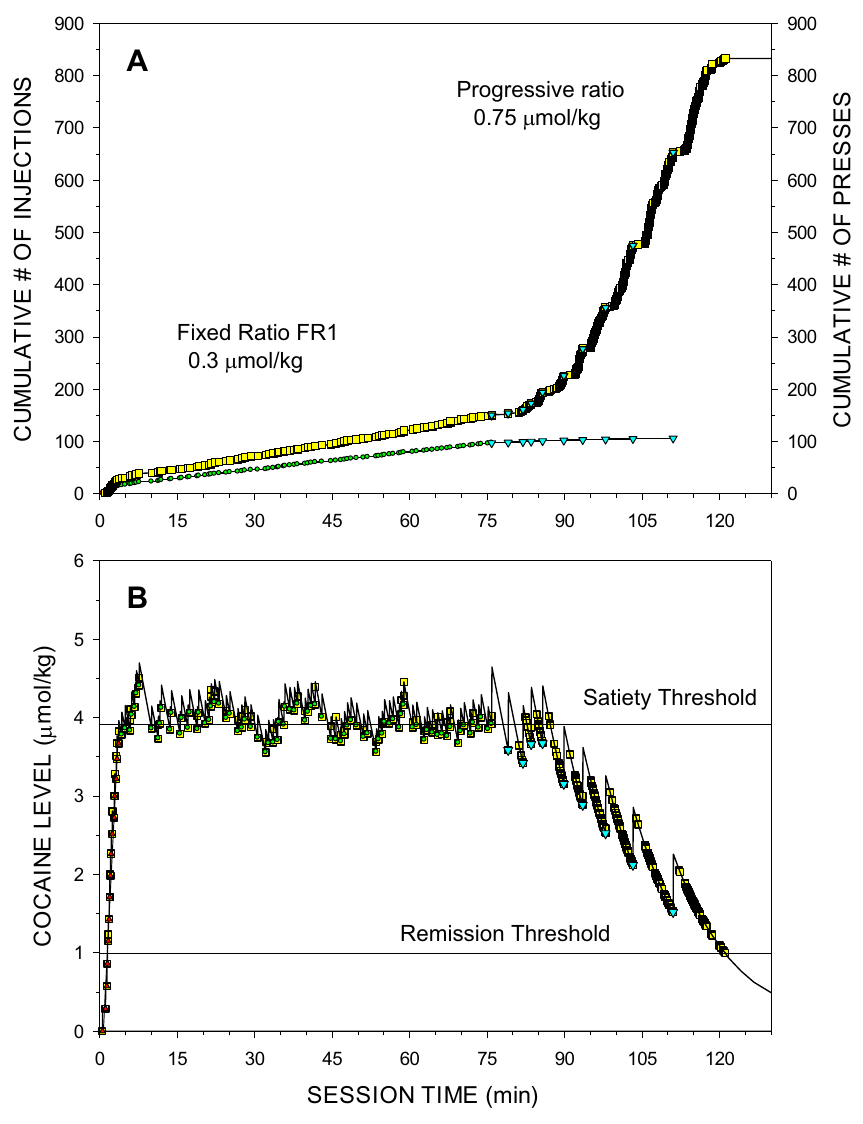
Figure 2. Cumulative records of events ( A ) and the calculated levels of cocaine ( B ) at the time of each event during a representative self-administration session under FR1 and PR schedules of delivery of low unit doses of cocaine (0.3 and 0.75 µmol/kg, respectively). There were two kinds of events: lever presses and drug injections. Open squares represent each active lever press. Red triangles represent loading injections. Green circles represent cocaine levels at the beginning of each injection during maintenance under the FR1 schedule at 0.3 μmol/kg unit dose. Cyan inverted triangles represent injections of 0.75 μmol/kg unit dose under the PR schedule. ( A ) The mean ± SEM inter-injection intervals during loading and maintenance phases under the FR1 schedule were 13.5 ± 2.2 s (red triangle) and 52.8 ± 3.0 s (green circle), respectively. Between post-injection pauses under the PR schedule, the mean ± SEM local inter-press interval was 3.09 ± 0.73 s ( LR = 19.4 ± 2.7 presses/min). The last completed ratio was 178. The number of presses after the last injection but before the last press, e.g., the number of final extinction presses was 184, therefore BP = 184 presses. ( B ) Horizontal lines represent mean ± SEM